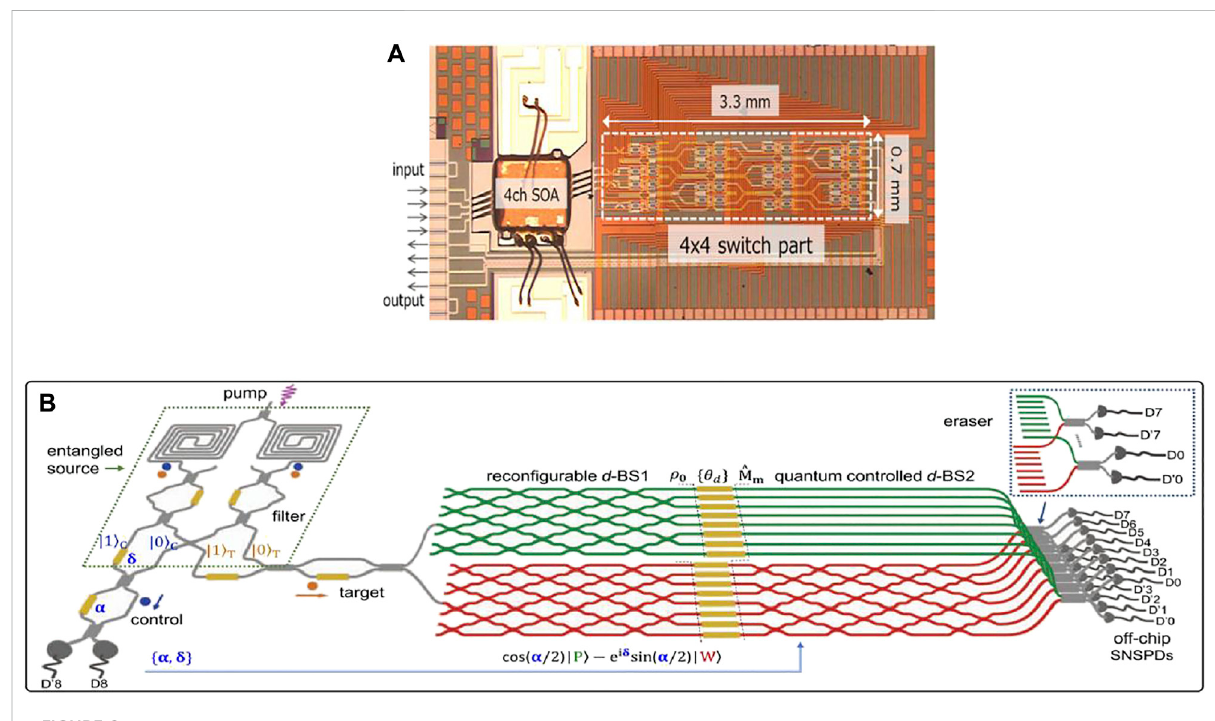
FIGURE 8 Applicationofsplitter inlargescale quantumchipandoptoelectronichybridintegration. (A) Themicroscopeimageoffabricated 4×4Siswitch with hybrid-integrated InP-SOA [154]. (B) Generalized multipath delay selection for large scale quantum nano photonic chips [153]. Figure reproduced with permission from: (A) , © 2018, Institute of Electrical and Electronics Engineers (IEEE); (B) , © 2021, Nature